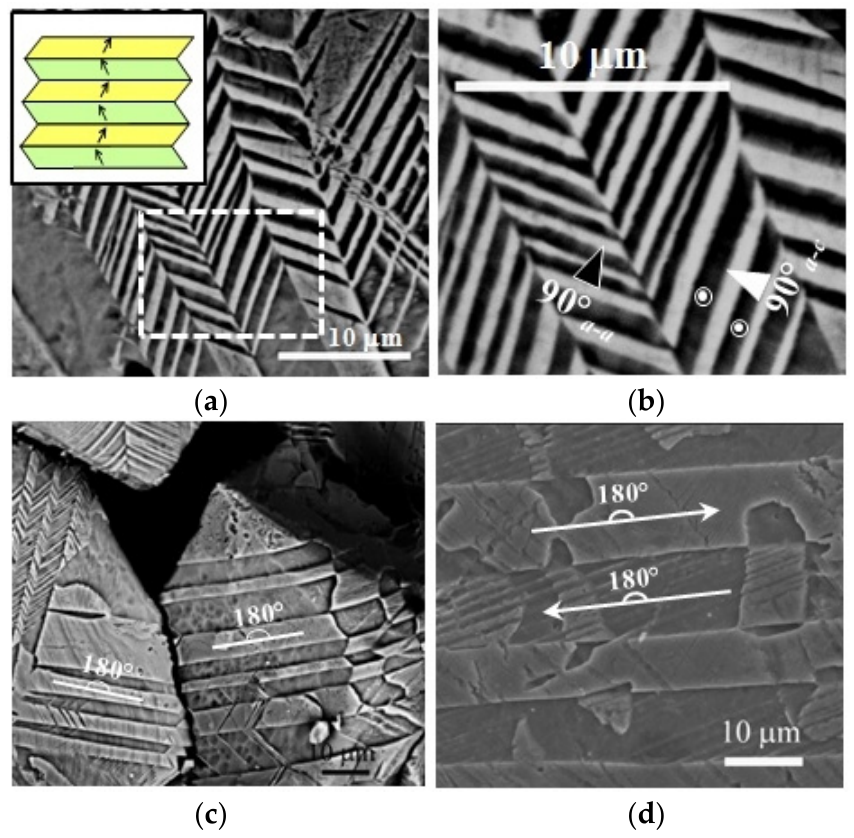
Figure 8. KNN samples prepared by microwave ‐ assisted hydrothermal synthesis. Representative microstructure showing ( a ) lamellar 90° a ‐ a; and ( b ) dagger ‐ shaped 90° a ‐ c domains. The inset shows a scheme of the 90° wall twin structure; ( c ) and ( d ) representative microstructure containing 180° domains [135].